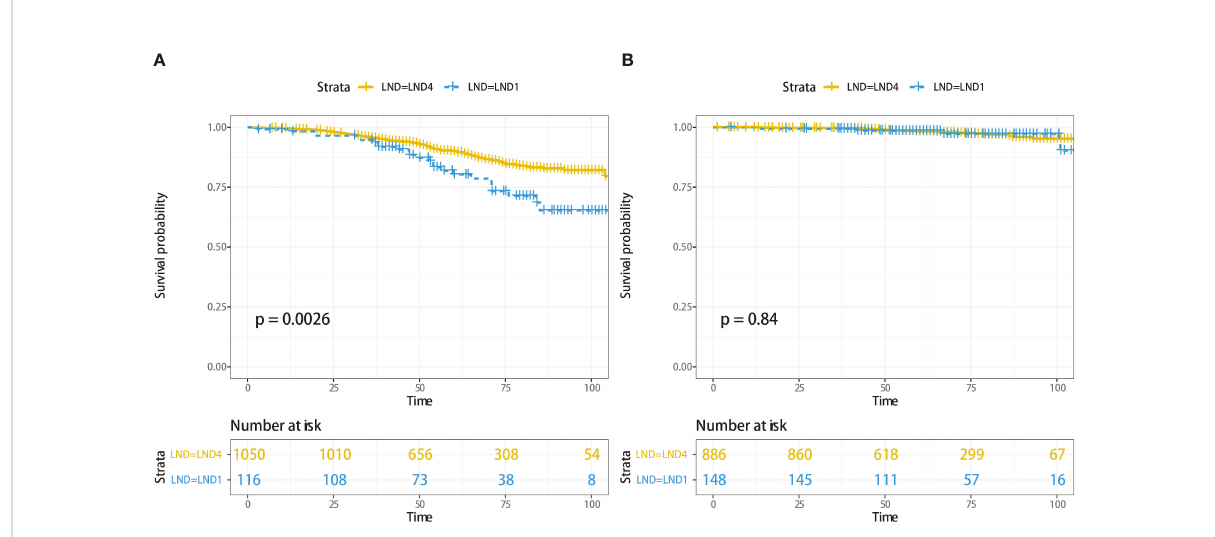
FIGURE 2 Cancer-speci fi c survival analysis for 1,166 patients with Gleason score ≥ 8 according to LND1 or LND4 (A) , and 1,034 patients with Gleason score ≤ 7 according to LND1 or LND4 (B)